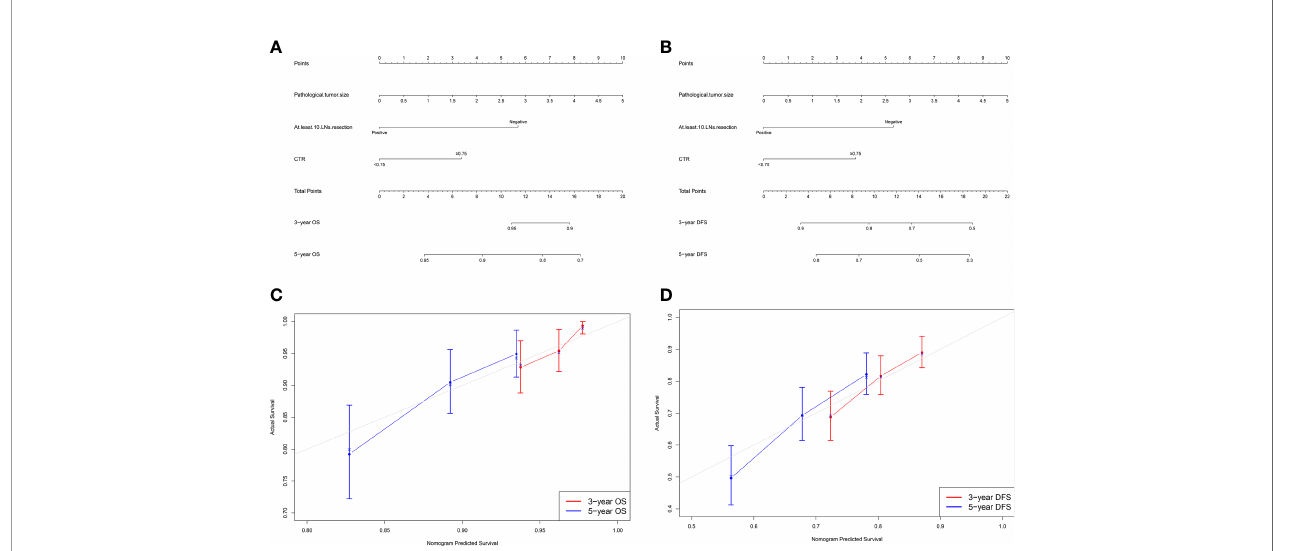
FIGURE 2 | Nomogram for predicting the 3-year and 5-year survival rates in patients with stage IB – IIA LUAD. (A) Overall survival (OS); (B) Disease-free survival (DFS). For each patient, the points of the three factors are represented as points by projecting them onto the uppermost line (point scale). For panel (A) , patients with less than 10 LNs resection get 6 points, otherwise 0 point; patients with CTR ≥ 0.75 get 3 points, otherwise 0 point. For panel (B) , patients with less than 10 LNs resection get 5 points, otherwise 0 point; patients with CTR ≥ 0.75 get 4 points, otherwise 0 point. For panels (A, B) , multiply tumor size by two is the tumor size point of each patient. Totaling the points of three variables is the total point, and projecting the total point value downward onto the bottommost line can determine the probability of 3- and 5-year OS and DFS. Calibration curves for predicting the 3- and 5-year survival rates in stage IB – IIA LUADs. (C) OS; (D) DFS. The x-axis represents the predicted probability of survival, the y-axis represents the actual probability of survival, and the ideal line is the diagonal of the graph. The closer that the drawn line is to the diagonal, the better is the calibration model. N = 501; The error bars indicate 95% CIs of actual survival.